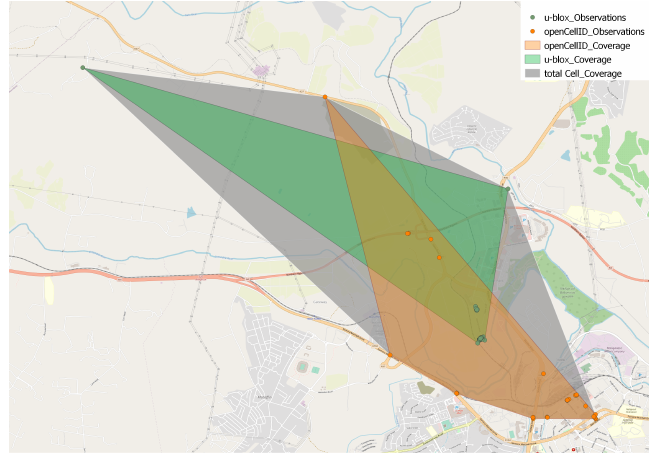
Figure 11. Integration of different sources: a cell reconstructed from 37 observations of the OpenCel- lID dataset and 87 observations of the u-blox